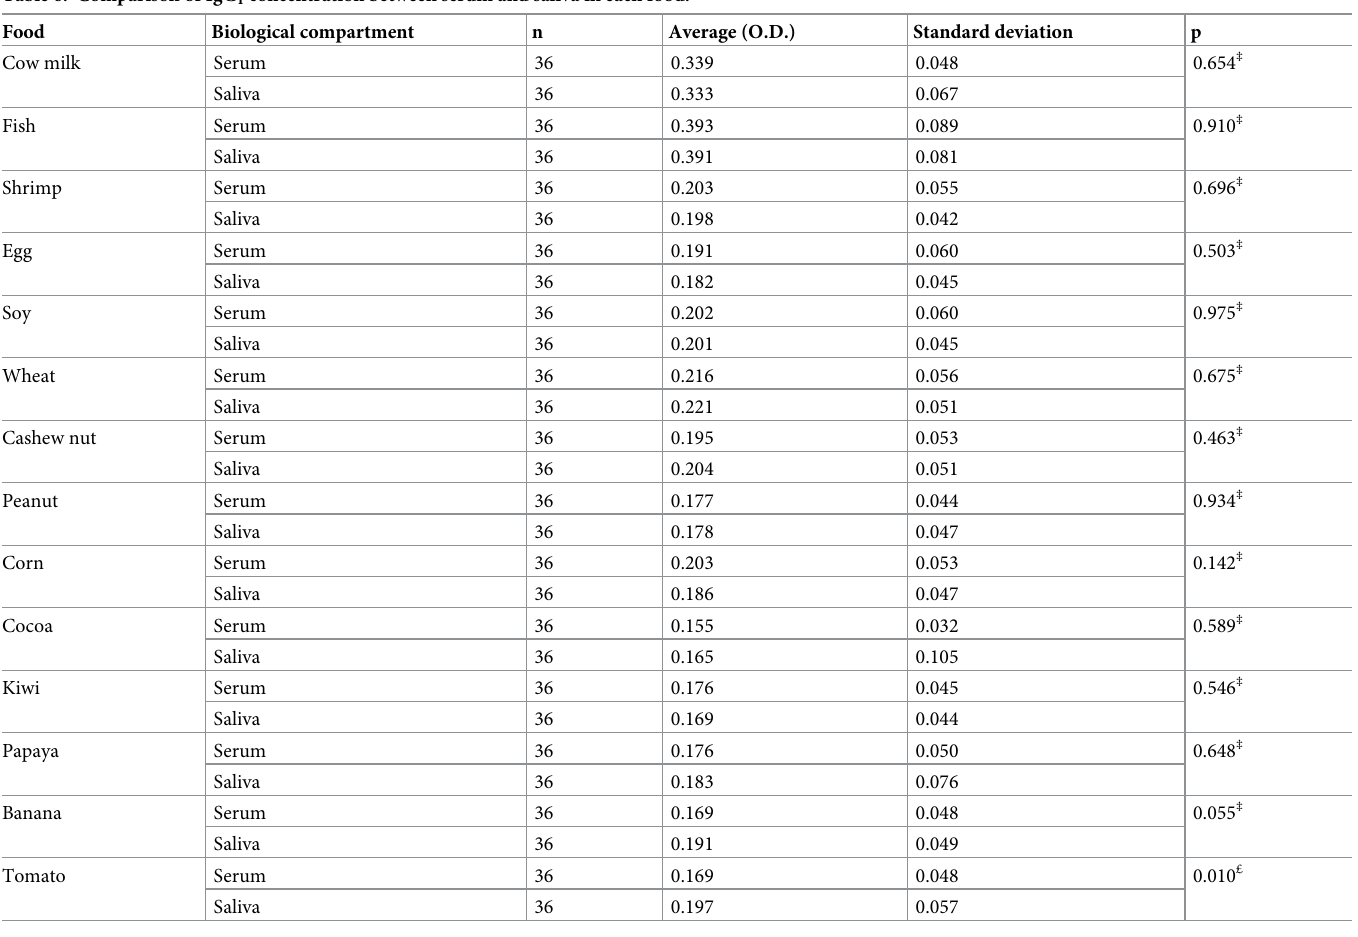
Table 6. Comparison of IgG 1 concentration between serum and saliva in each food.